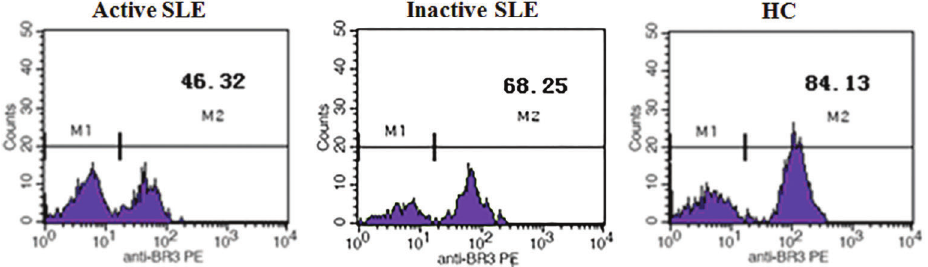
Figure 3. Representative plots of mean fl uorescence intensity (MFI) of BAFF receptor 3 (BR3) on CD19 + B cells in the three groups. SLE: systemic lupus erythematosus; HC: healthy control; M1: MFI of negative control; M2: MFI of positive